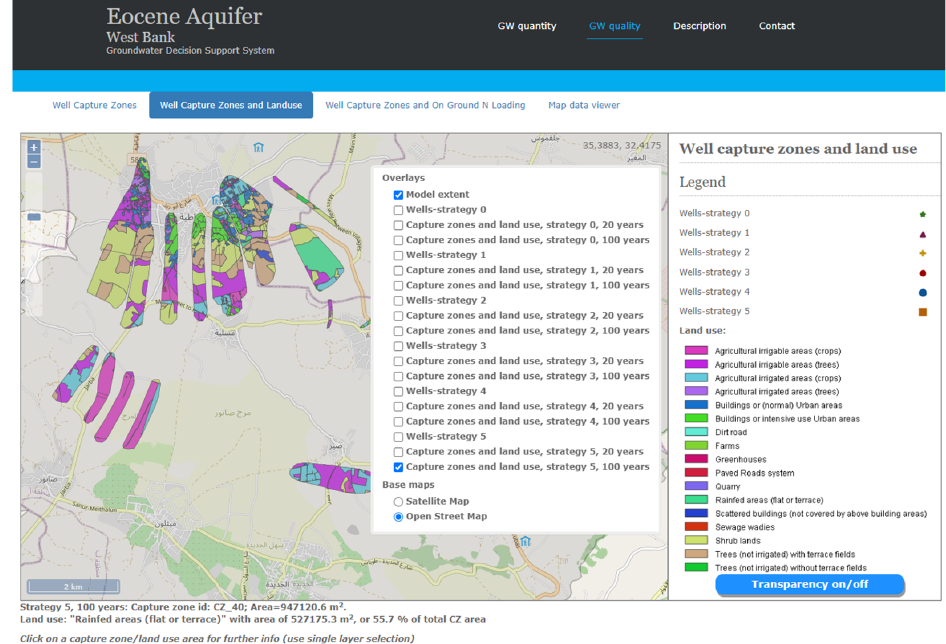
Figure 31. Land use within wells capture zones for strategy 05.